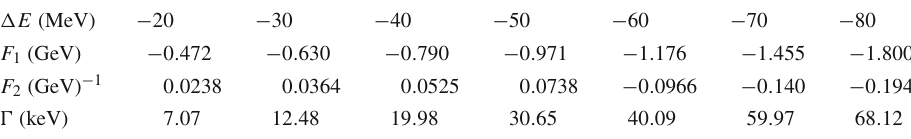
Table 3 The form factors and decay widths for different binding energies of B 0 π + ( I = 3